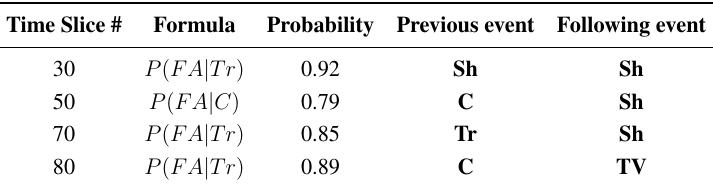
Table 5. List of confirmed